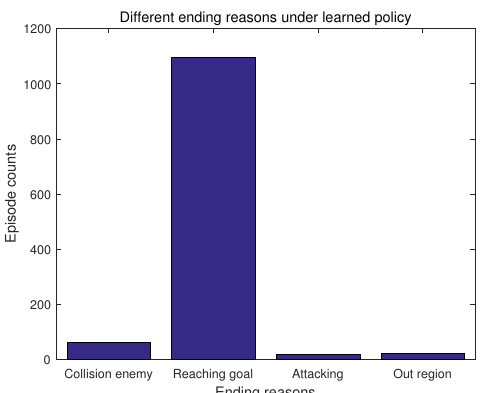
Figure 16. The total numbers of different ending reasons when using the learned